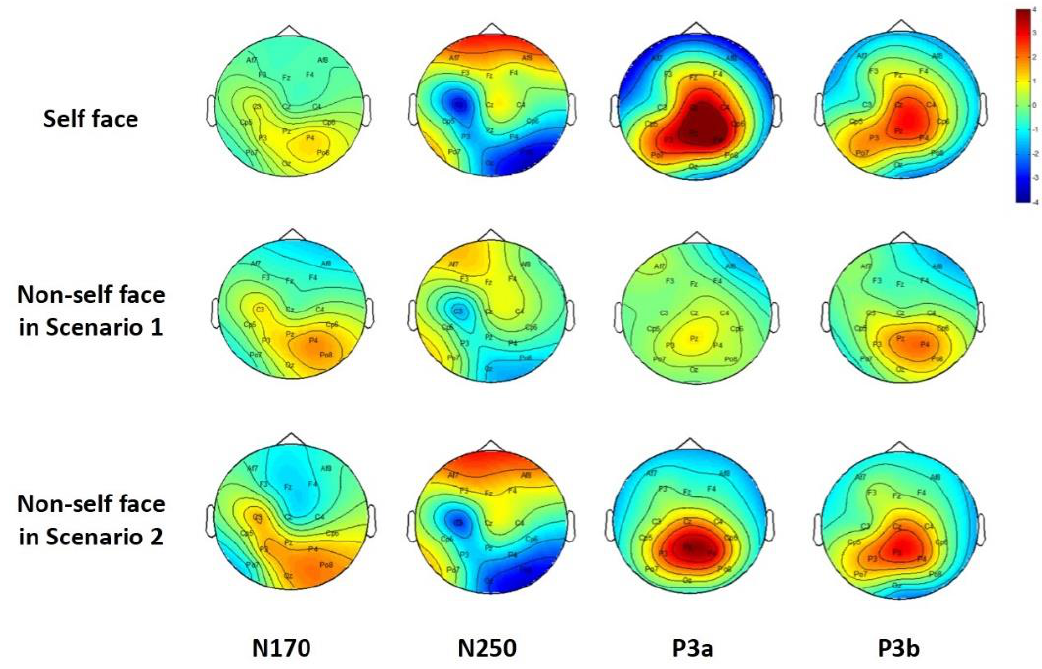
Figure 4. The topographic maps of EEG data for self-face and non-self-face.